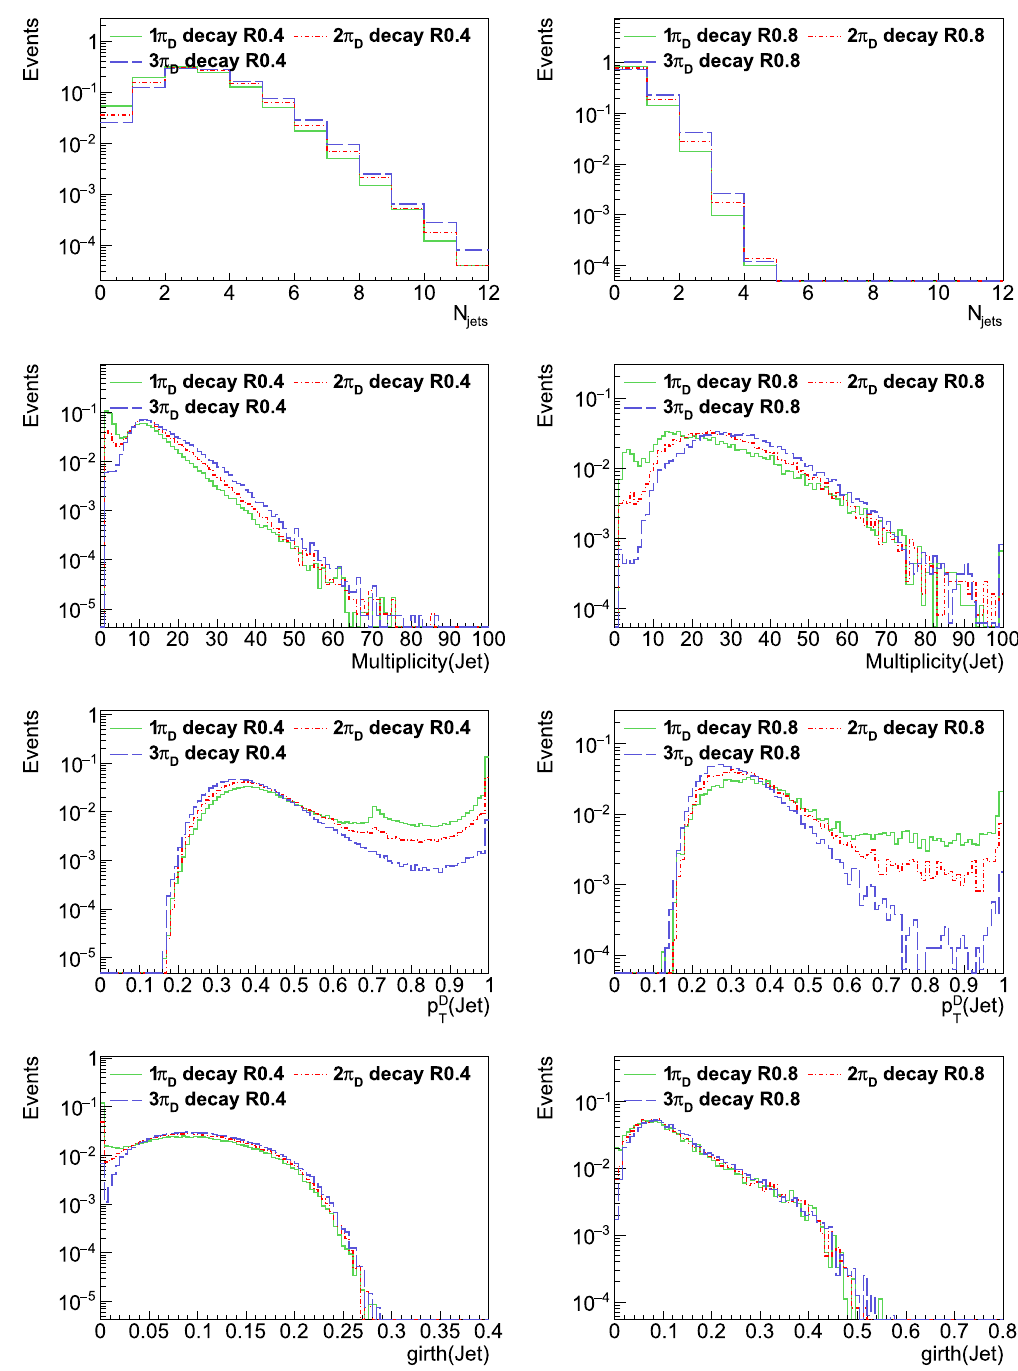
Fig. 48 Comparison of reco-level variables between different number of unstable diagonal dark pions for probVector=0.5 . Left column show the R = 0 . 4 jets and right column R = 0 . 8 jets. First row is the